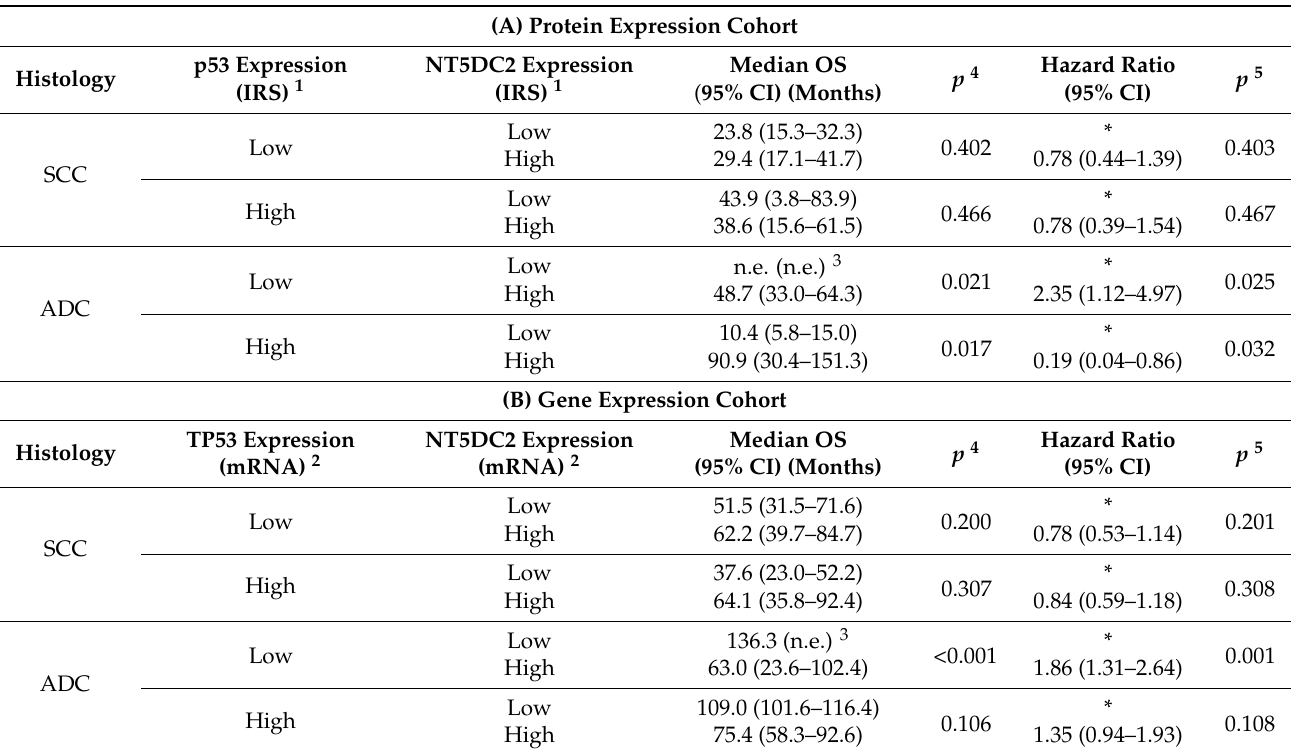
Table 4. Survival analysis in the protein expression cohort. NT5DC2 survival effect in Adenocarci- noma is highly dependent on p53